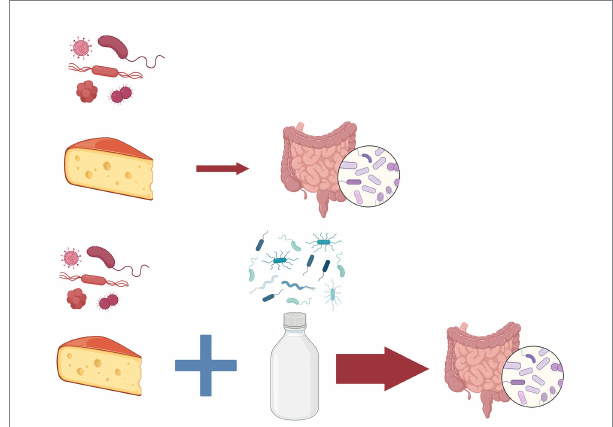
FIGURE 2 Microbiome succession. In an experiment (Milani et al., 2019)